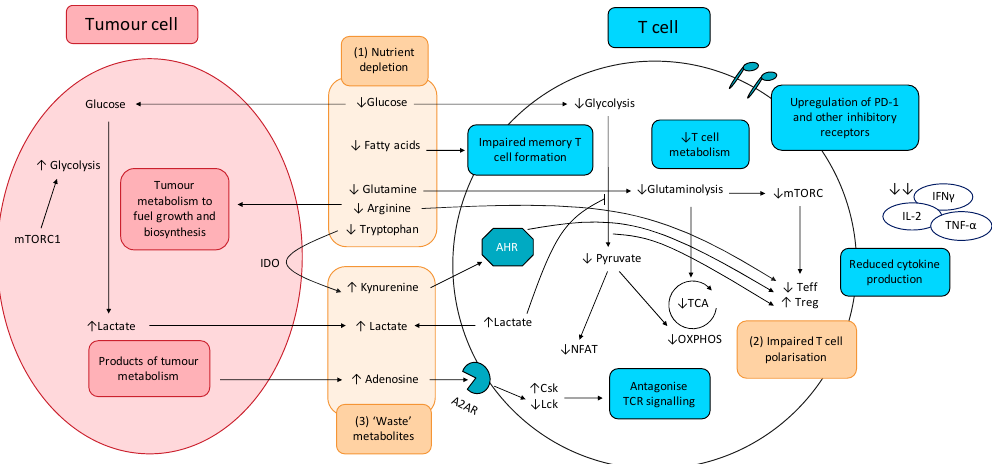
Figure 3. E ff ect of tumour metabolism on T cell function. (1) Altered cancer cell metabolism results in nutrient competition, depriving T cells of essential nutrients essential for robust anti-tumour activity, including glucose and key amino acids. Resultant exhausted T cell phenotype shows upregulation of inhibitory receptors including PD-1, CTLA-4, TIM-3, LAG-3, and TIGIT, impaired production and release of e ff ector cytokines (IFN γ , IL-2, and TNF- α ), as well as impaired degranulation. (2)